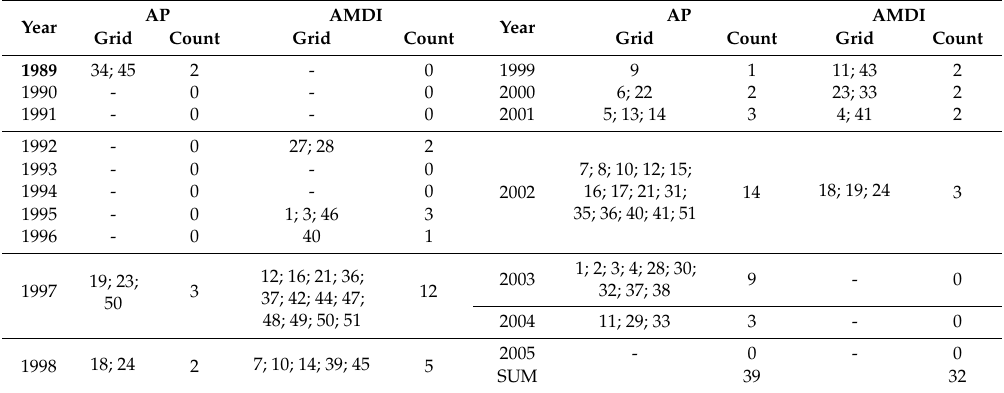
Table 3. Abrupt change detection results of the AP (annual precipitation) series and AMDI (annual marginal disorder index) series during 1979–2015 at 51 selected